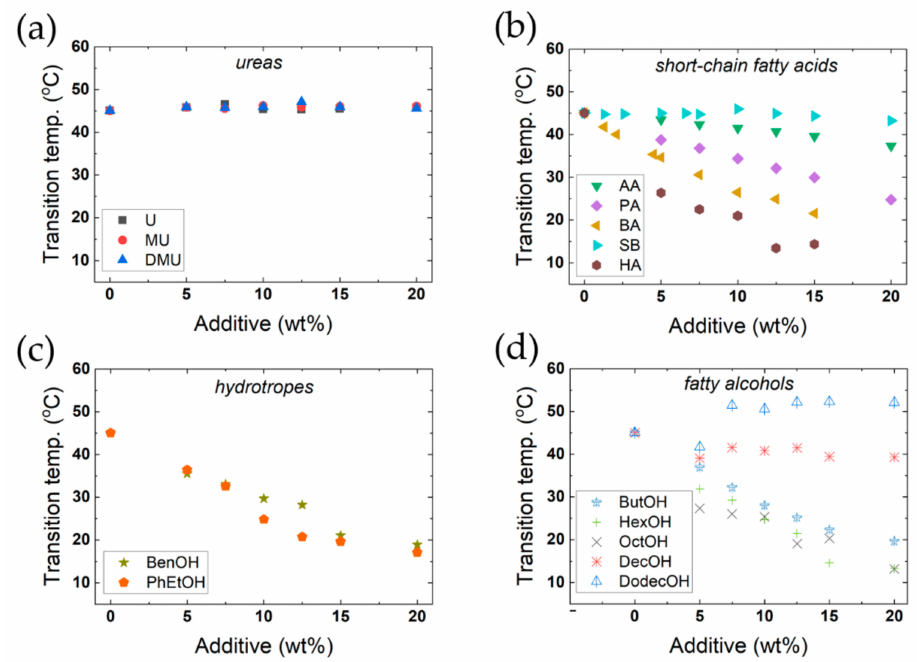
Figure 9. Effect of added additives on the main phase transition temperature of DODAC in water. ( a ) Urea and two urea derivatives. U-urea, MU-methyl urea, DMU-dimethyl urea. ( b ) Short-chain fatty acids and sodium